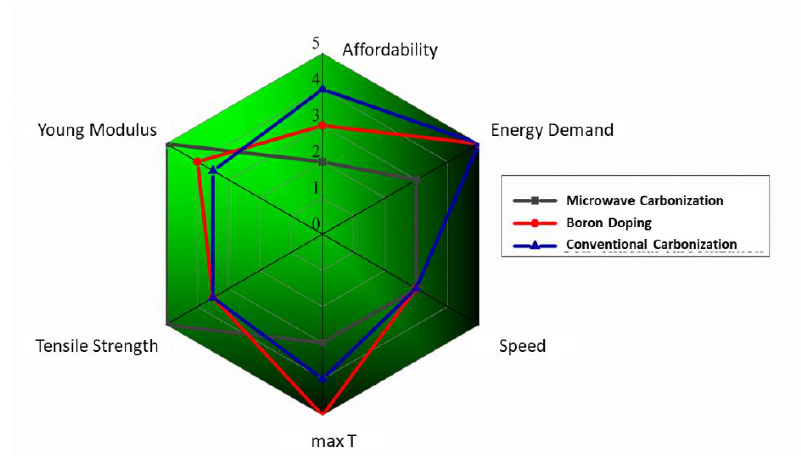
Figure 10. Carbonization technologies involved in high strength and high modulus CF synthesis.